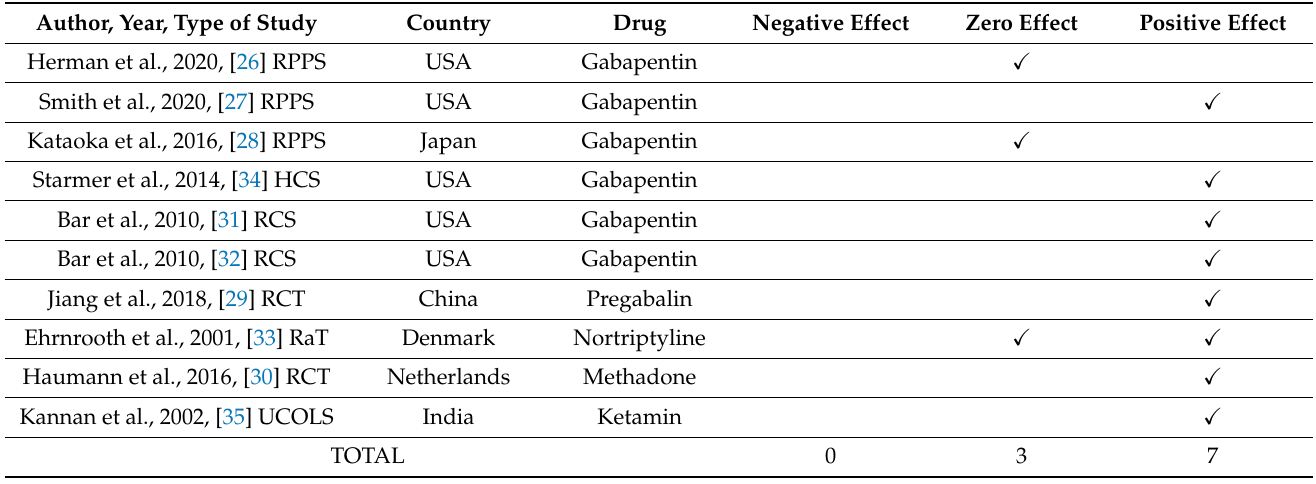
Table 4. Results of the